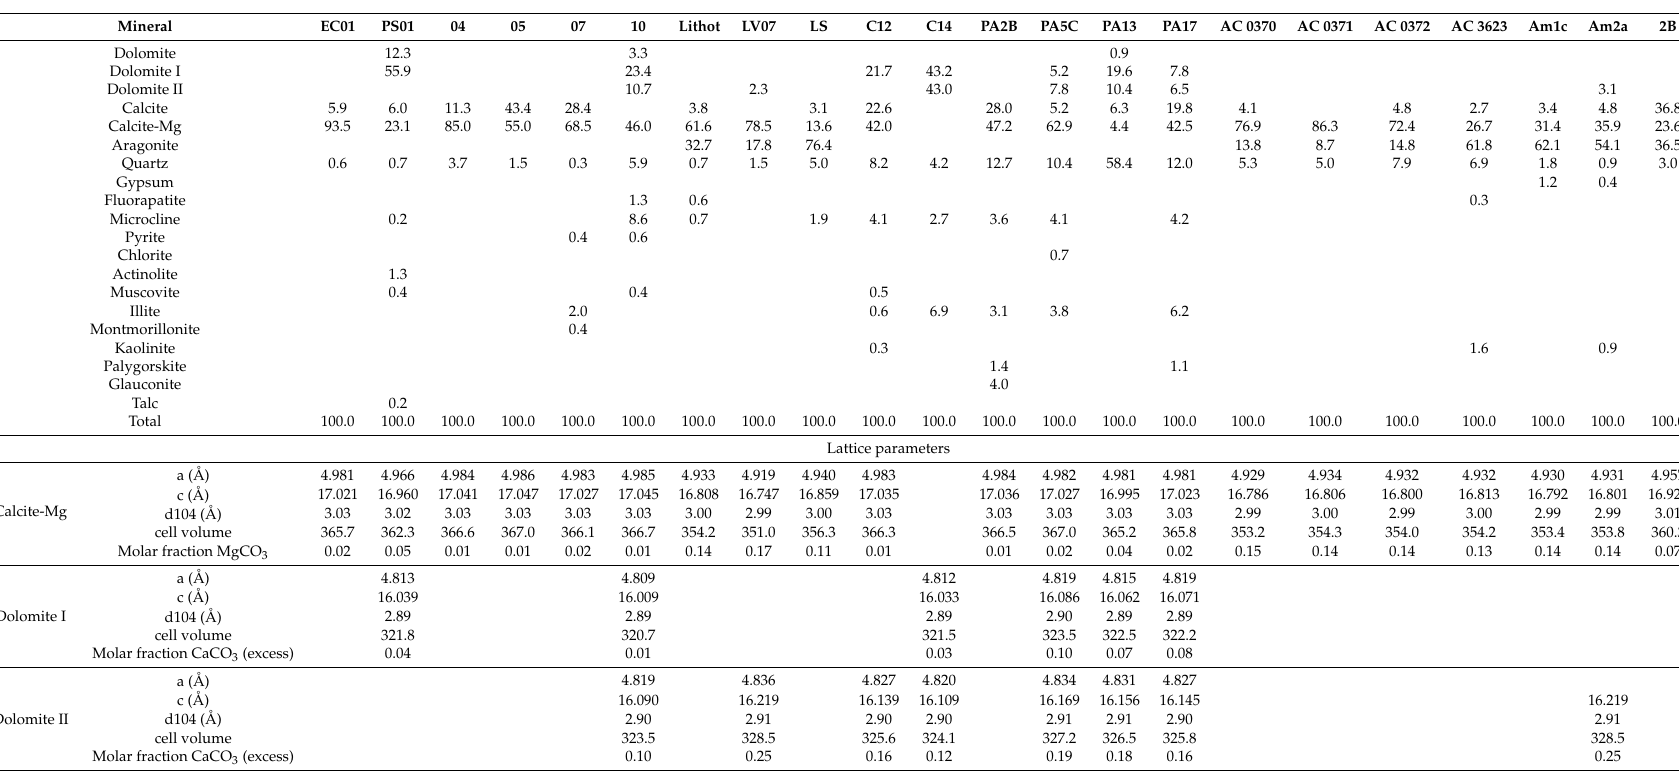
Table 3. Mineral quantification based on XRD and fundamental parameter Rietveld refinement (wt %), as well as the molar fraction of Mg-for-Ca substitution in calcite and the CaCO 3 excess in non-stoichiometric low calcium-excess (dolomite I) and high calcium-excess (dolomite II) dolomite. Mineral